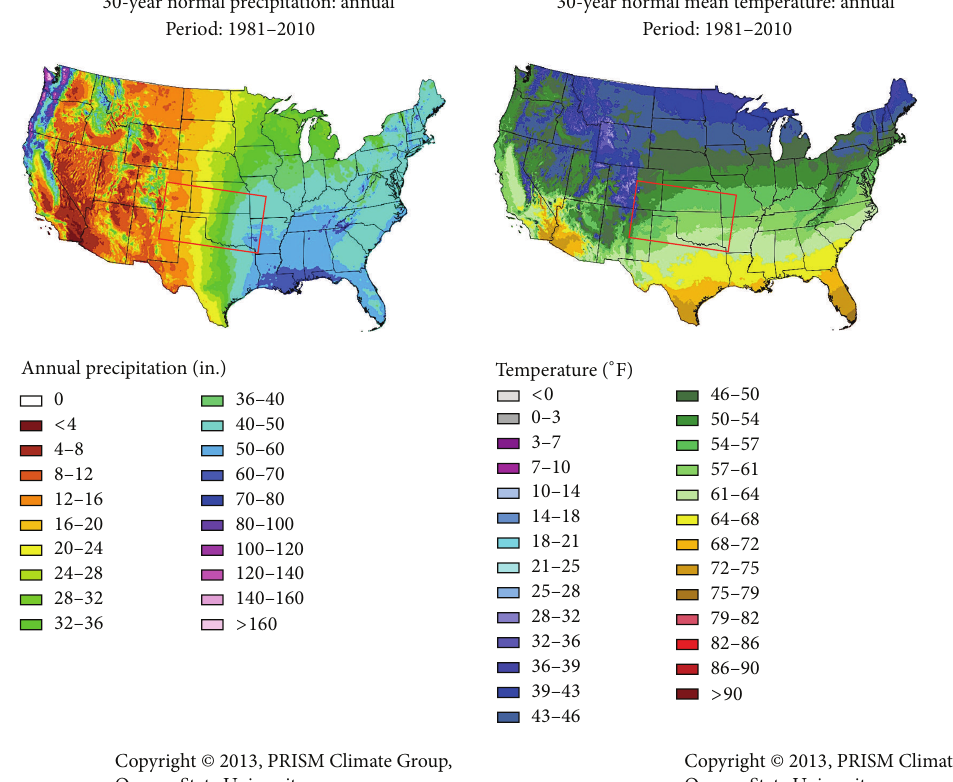
Figure 1: It shows the precipitation and temperature gradients across the United States. In the Arkansas-Red River Basin, the precipitation gradient is orthogonal to the temperature gradient. Approximate area encompassed by basin is outlined in red. Images via PRISM Climate Group